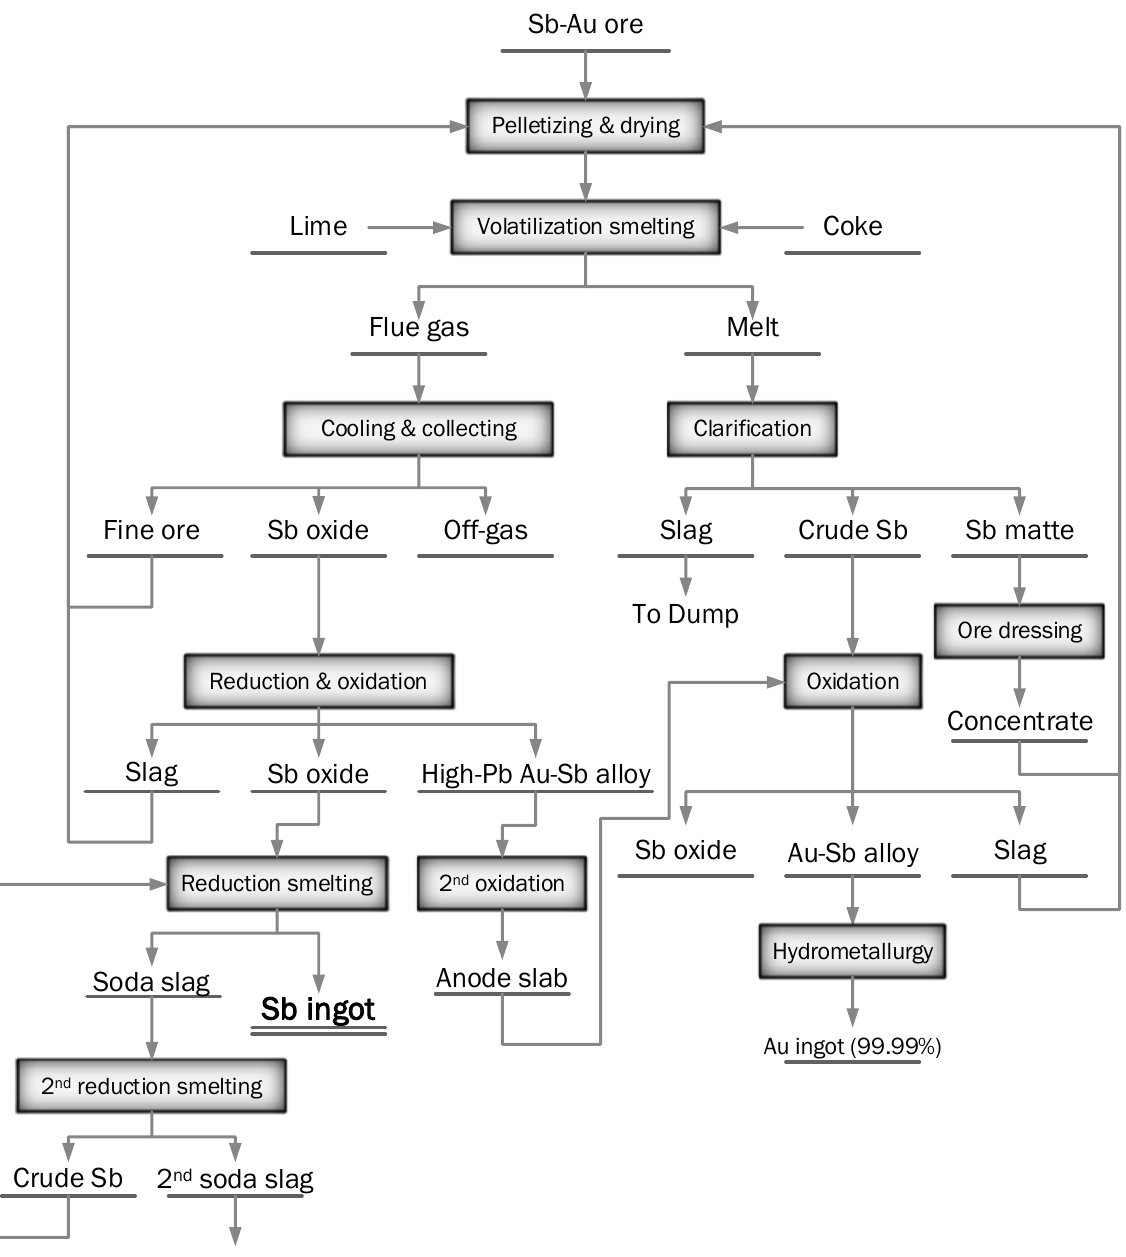
Figure 7. Flowsheet of the blast furnace volatilization smelting of antimony-gold ore (adapted from [19]).